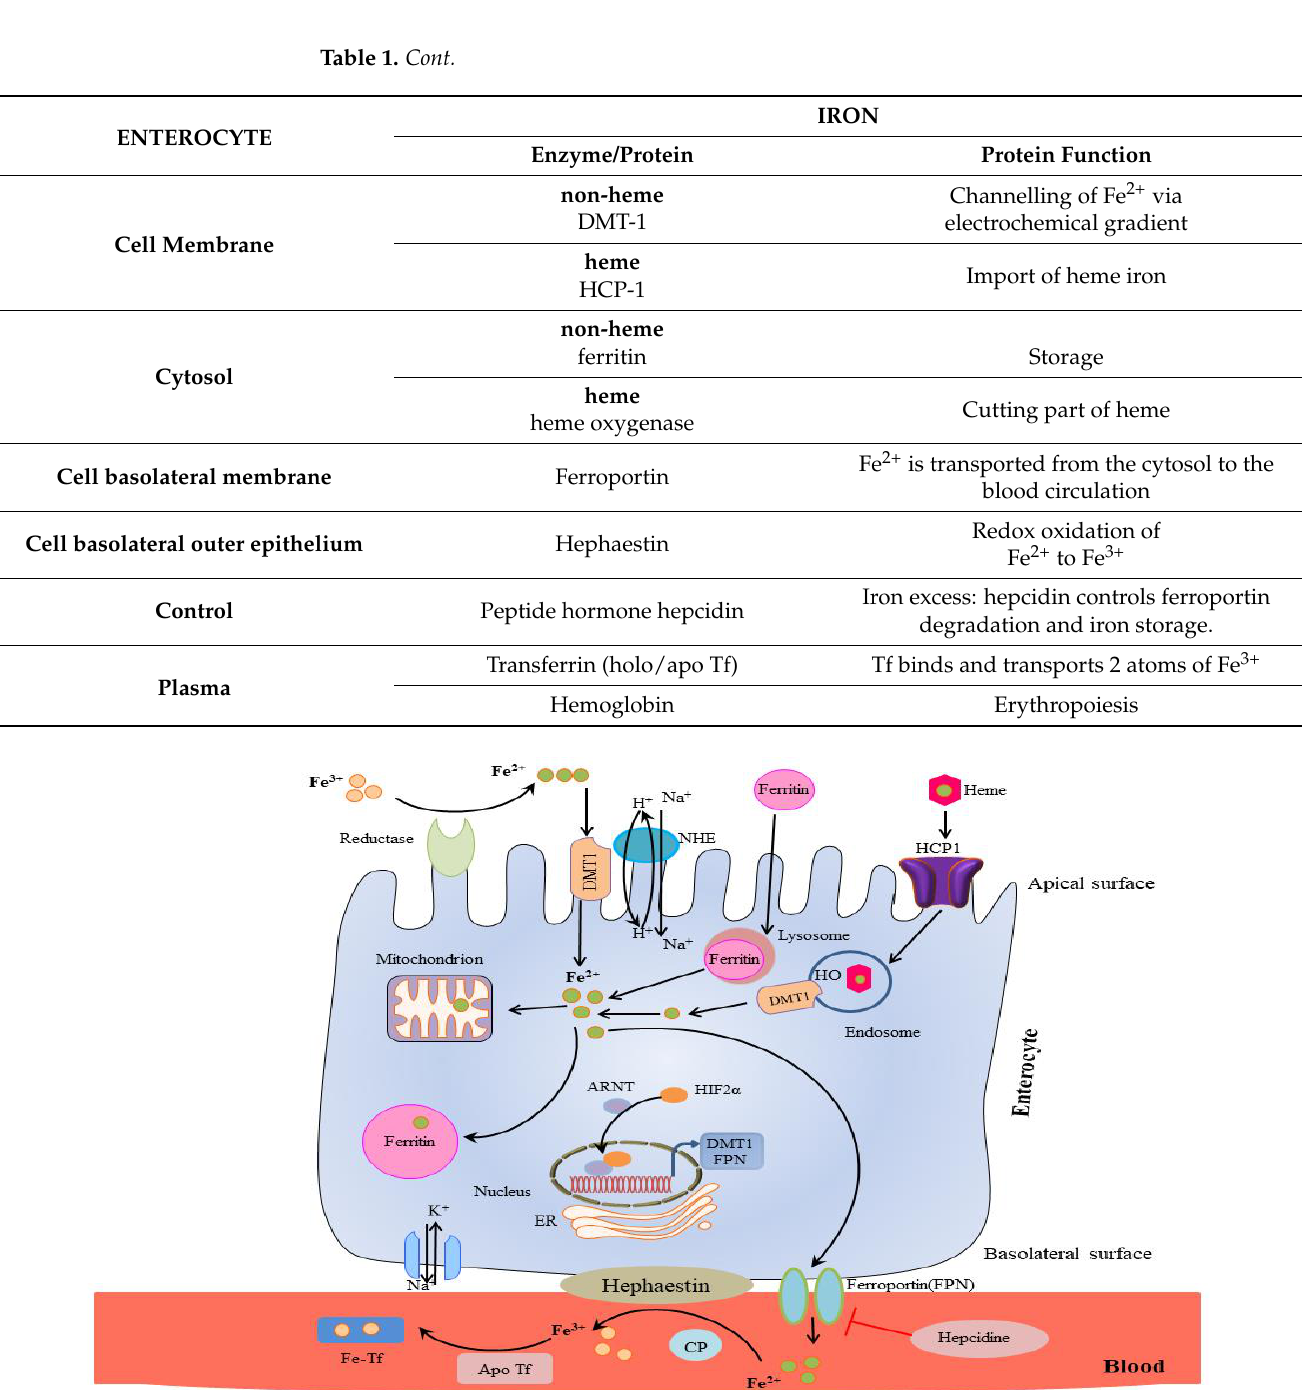
3+ before entering in